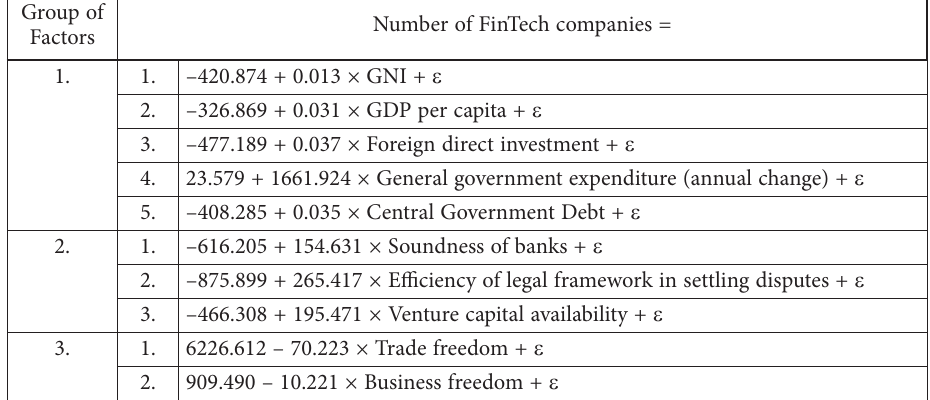
Table 3. Statistically significant equations for simple linear regression (source: authors) Group of Factors